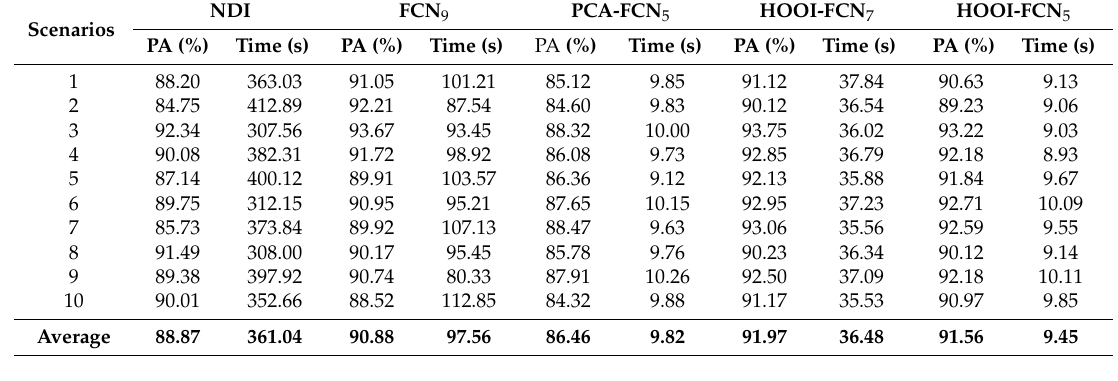
Table 3. Quantitative results for 10 test MSIs running in a NVIDIA GeForce GTX 1050 Ti GPU, Intel core i7 processor, 8 Gb RAM, SSD 128 Gb, and HDD 1 Tb. Values in blue and red represent the highest